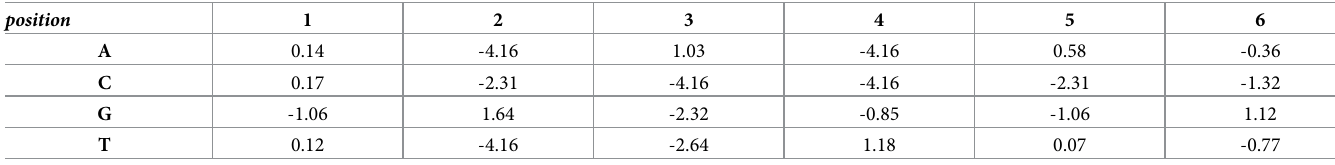
Table 1. A position weight matrix in the nucleotide sequence